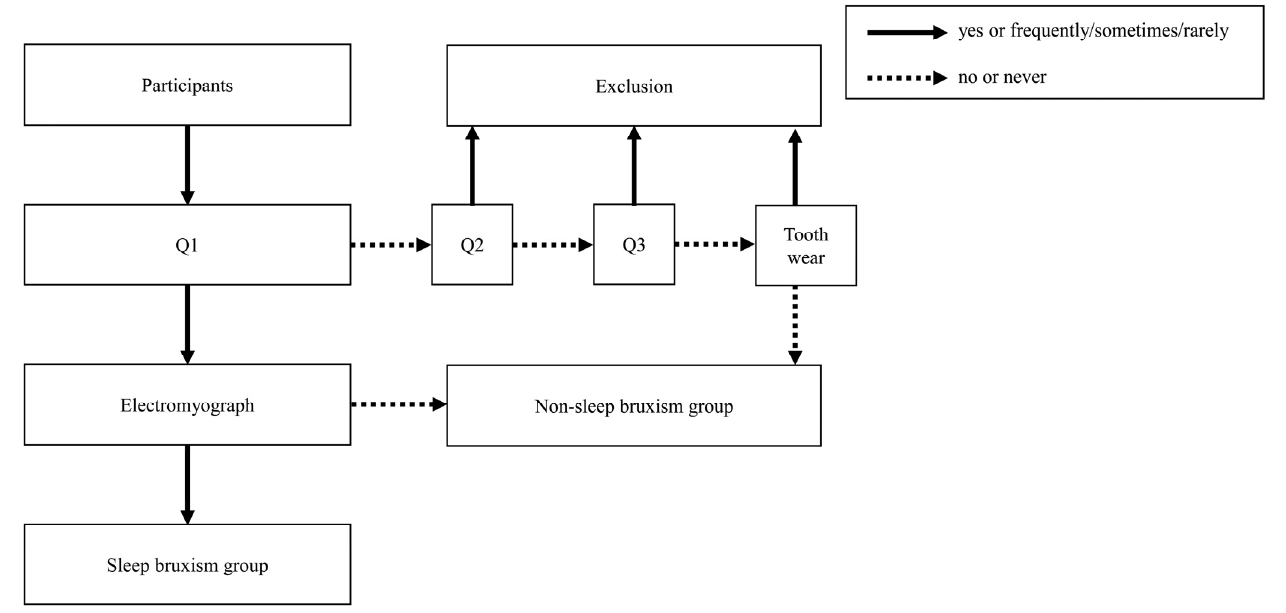
Figure 1. Protocol for assignment to the sleep bruxism and non ‐ sleep bruxism groups.